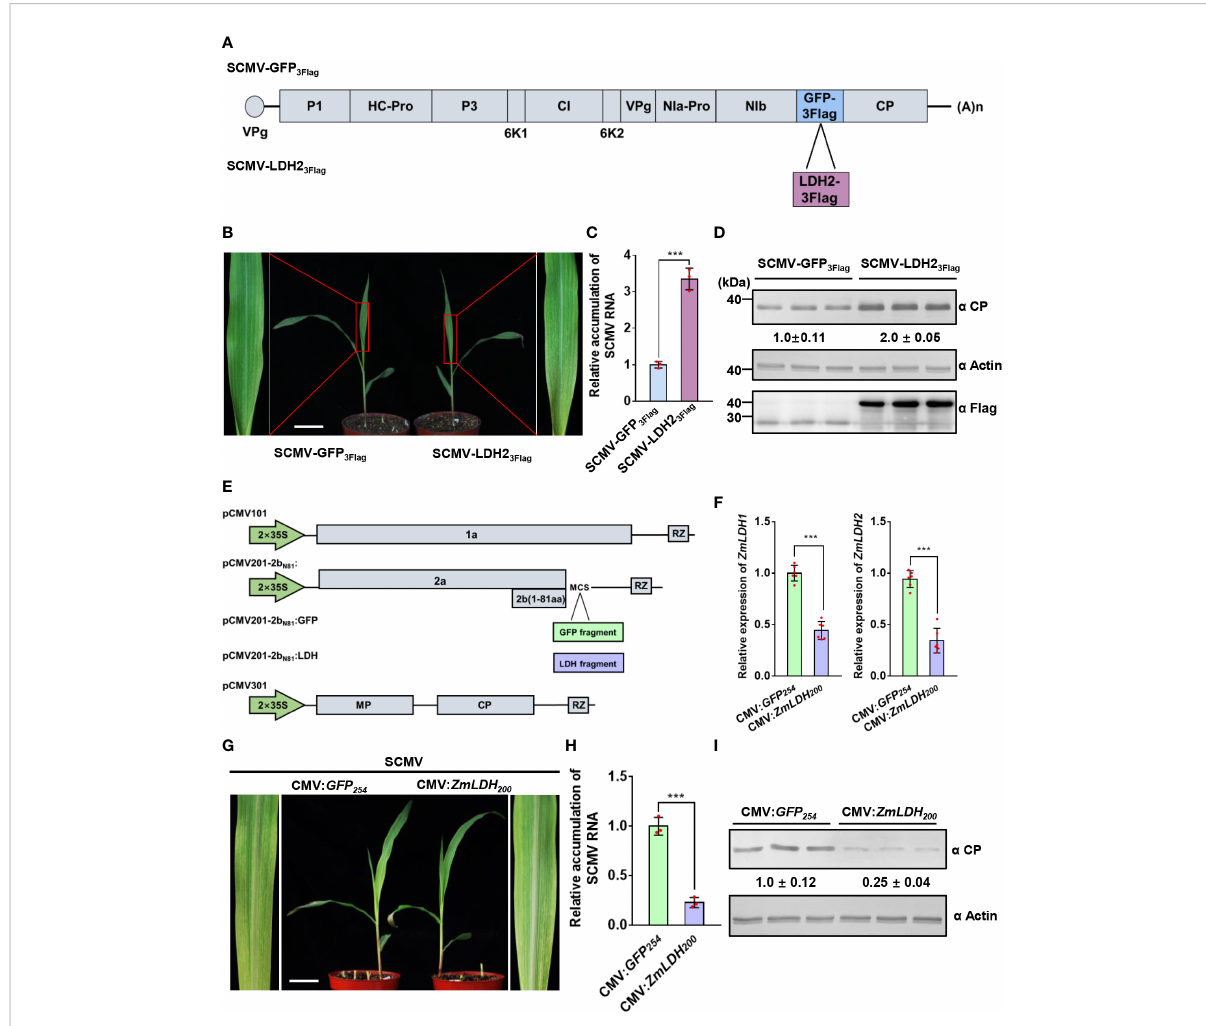
FIGURE 4 ZmLDH is essential for robust SCMV infection. (A) Schematic representation of SCMV-related constructs. GFP 3Flag or LDH2 3Flag is inserted between NIb and CP to obtain SCMV-GFP 3Flag or SCMV-LDH2 3Flag . (B) Mosaic symptoms in SCMV-LDH2 3Flag -infected plants were more severe than that in SCMV-GFP 3Flag -infected plants. Scale bars = 4 cm. (C) Relative accumulation levels of SCMV genomic RNA, determined by RT- qPCR, in 1 SLs of SCMV-GFP 3Flag - or SCMV-LDH2 3Flag -infected plants at 5 dpi. The results are represented as the means ± SE (n=3). Statistical differences between the treatments were determined using unpaired Student ’ s t -test (two-tailed), *** P < 0.001. (D) Detection of SCMV CP, GFP 3Flag , and LDH2 3Flag in 1 SLs of SCMV-GFP 3Flag - or SCMV-LDH2 3Flag -infected plants at 5 dpi through western blotting analysis. The samples harvested from the SCMV-GFP 3Flag -infected plants were used as controls. The detected protein bands were visualized using the ImageJ software. The numbers between the two panels are the relative ratios of SCMV CP accumulated in the SCMV-LDH2 3Flag -infected plants verses the control plants. The amount of SCMV CP in the control plants is arbitrarily presented as 1.0. The actin bands in the lower panels are used to show sample loadings. (E) Schematic representation of ZMBJ-CMV-based gene silencing vector pCMV101, pCMV201-2b N81 and pCMV301. Fragments of GFP and LDH were separately cloned into pCMV201-2b N81 vector to result in pCMV201-2b N81 :GFP and pCMV201-2b N81 :LDH. (F) Expression levels of ZmLDH1 and ZmLDH2 were analyzed through RT-qPCR using gene speci fi c primers. Data are represented as the means ± SE (n=6). Statistical differences between the treatments were determined using unpaired Student ’ s t -test (two-tailed), *** P < 0.001. (G) Silencing of ZmLDH expression in maize with CMV vector alleviated SCMV mosaic symptoms in maize leaves. The maize plants inoculated with CMV : GFP 254 were used as the controls. All maize leaves were photographed at 7 dpi of SCMV infection. Scale bars = 4 cm. (H) Relative accumulation levels of SCMV genomic RNA, determined by RT-qPCR, in 1 SLs of the control or ZmLDH -silenced plants at 7 dpi. The results are represented as the means ± SE (n=3). Statistical differences between the treatments were determined using unpaired Student ’ s t -test (two- tailed), *** P < 0.001. (I) Accumulation levels of SCMV CP in the systemically infected leaves harvested from the control or ZmLDH -silenced plants at 7 dpi through western blotting analysis. The samples harvested from the CMV : GFP 254 -inoculated plants were used as controls. The detected protein bands were visualized using the ImageJ software. The numbers between the two panels are the relative ratios of SCMV CP accumulated in the ZmLDH -silenced plants verses the control plants. The amount of SCMV CP in the control plants is arbitrarily presented as 1.0. The actin bands in the lower panels are used to show sample